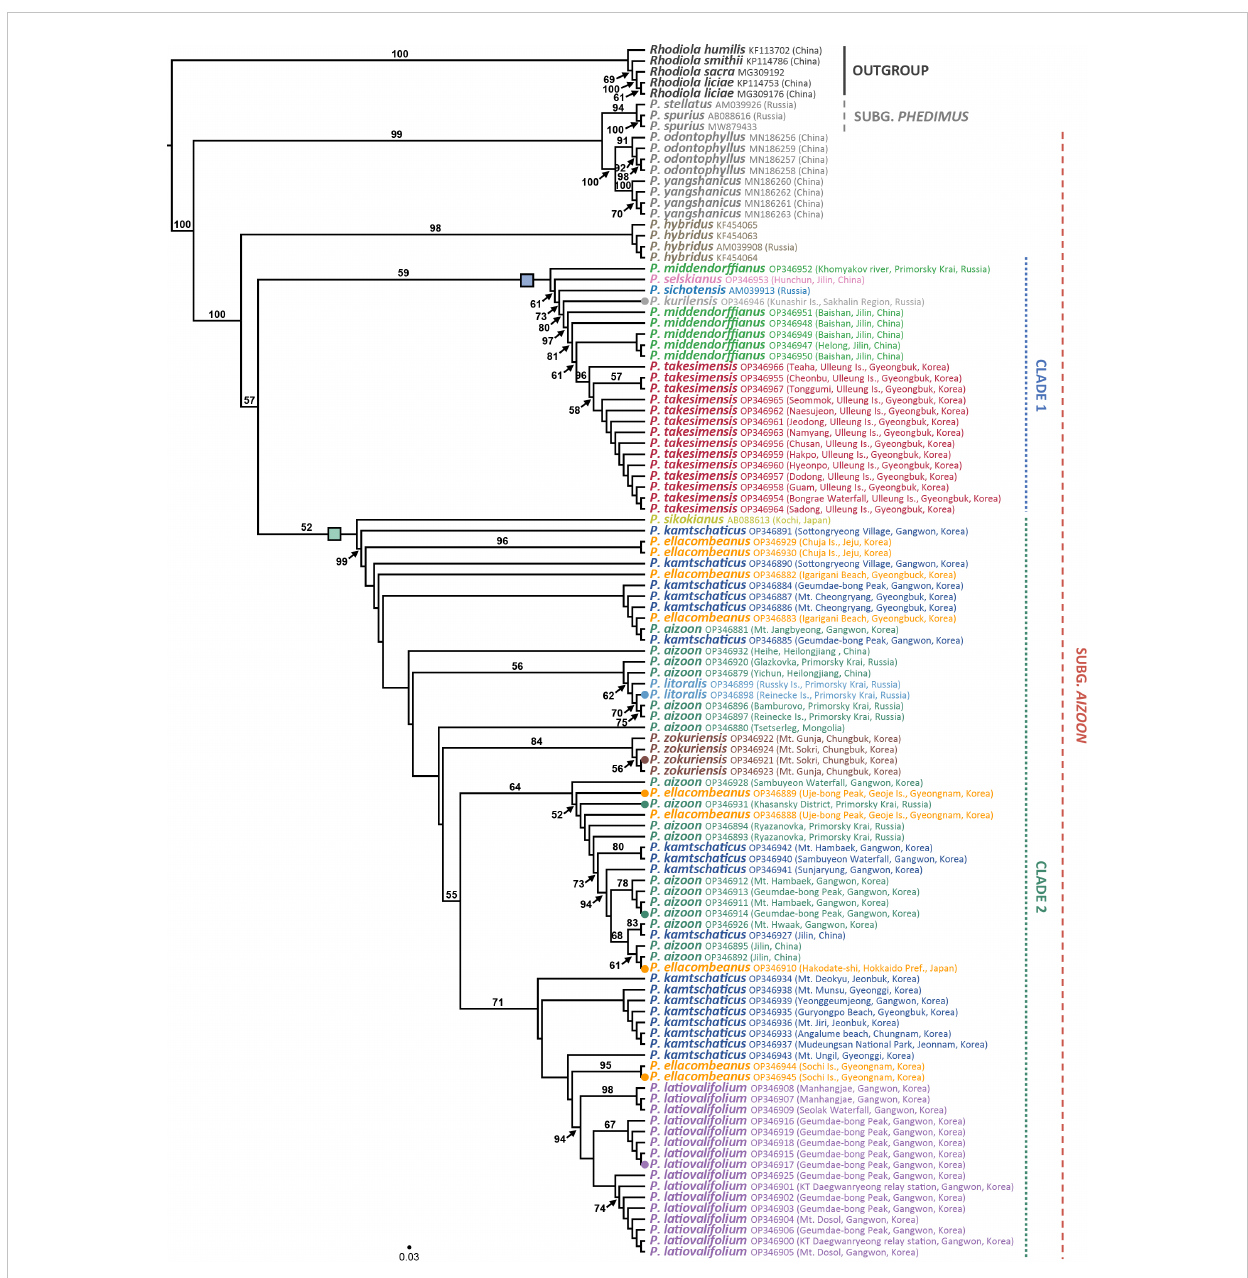
FIGURE 5 Maximum likelihood phylogeny of the genus Phedimus based on the nrDNA ITS sequences. Bootstrap support values >50% are shown below branches. Accessions in circles are sequenced for their complete plastomes, and the rectangles represent two major clades of subg. Aizoon